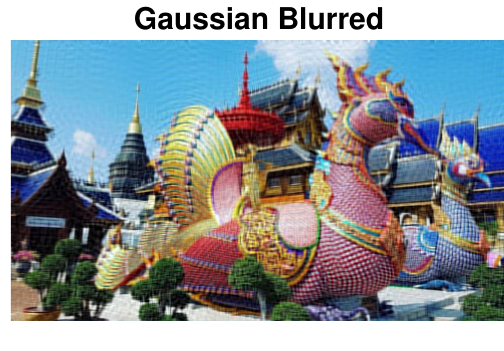
Figure 42. The reconstructed grey image of all cases using the proposed method (2) with PSNR = 24.